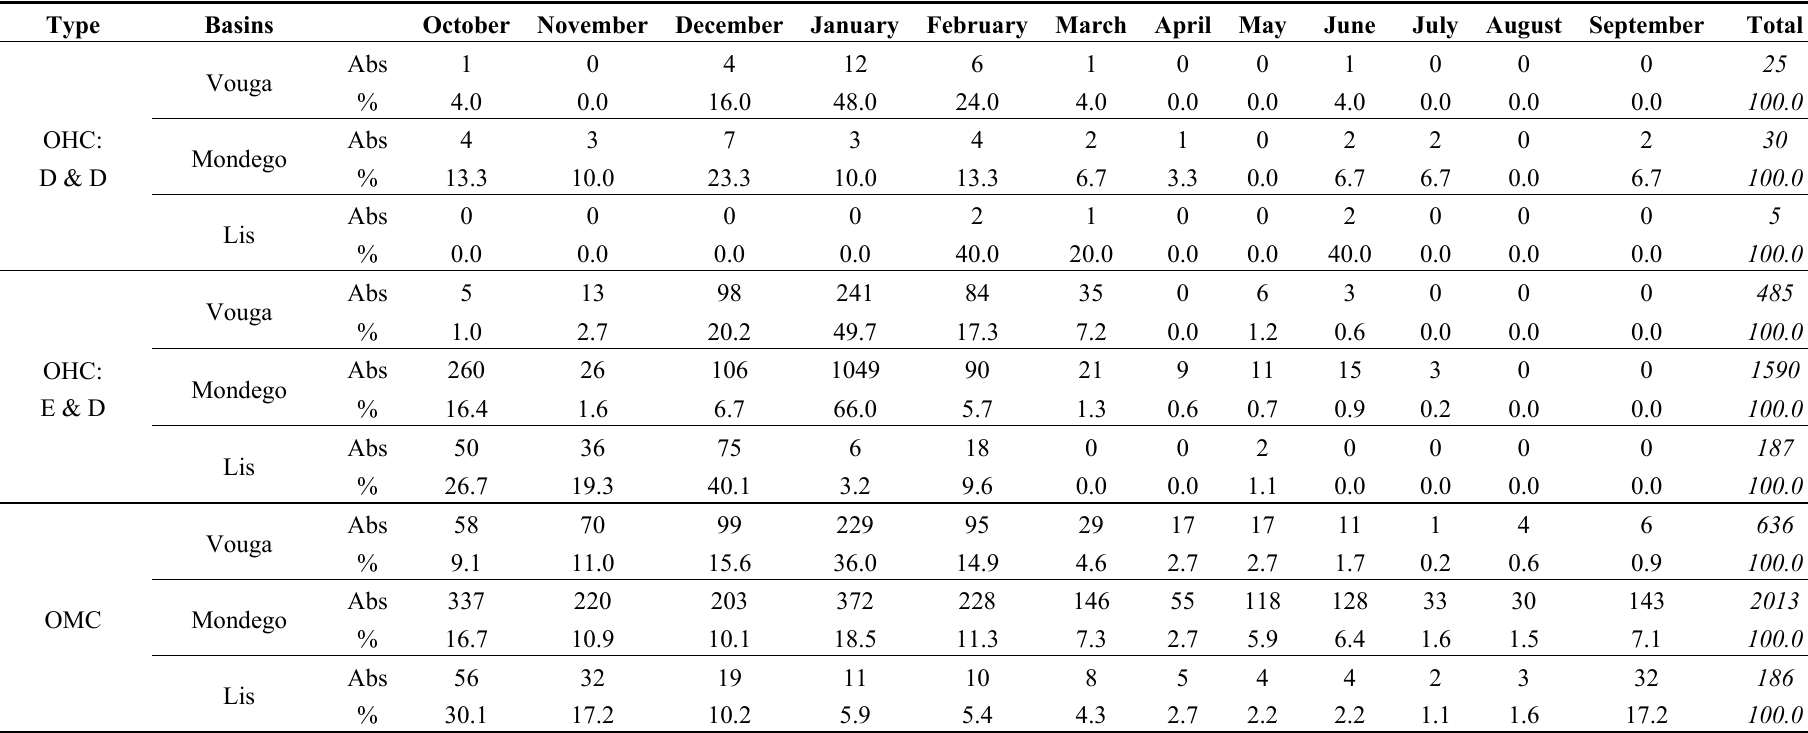
Table 6. Absolute and relative frequencies of the number of D & D and E & D persons, and number of occurrences uniquely with material consequences (OMC), by